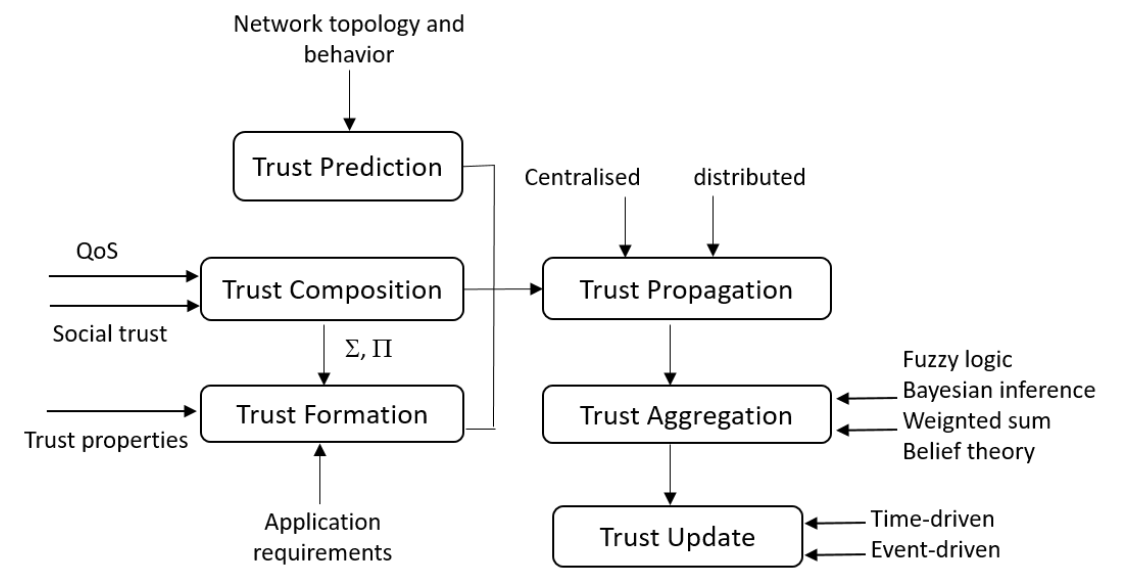
Figure 4. Trust computation